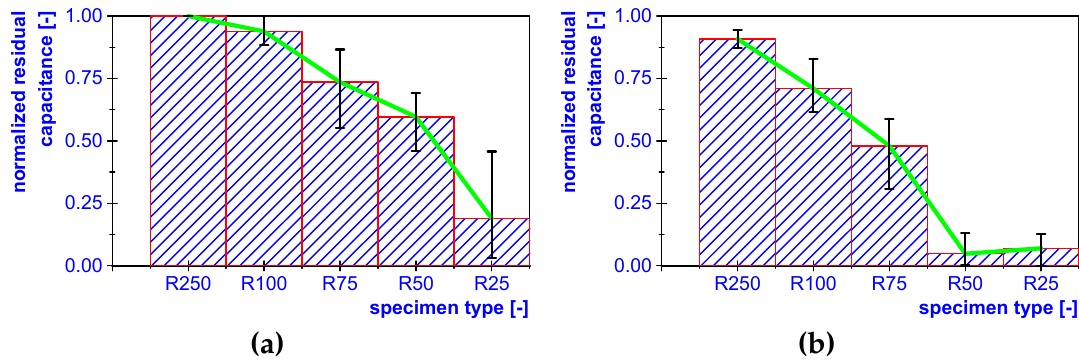
Figure 9. Normalized residual capacitance after deep drawing ( a ) inside the process window and ( b ) outside the process